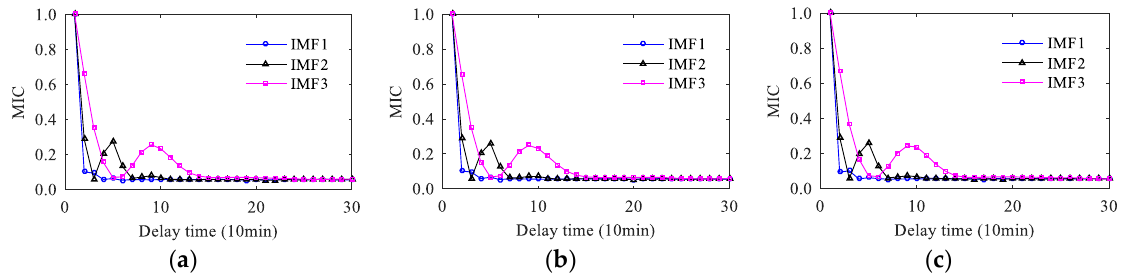
Figure 10. The variation law of MIC with the delay time for high-frequency components: ( a ) Case A; ( b ) Case B; ( c ) Case C.